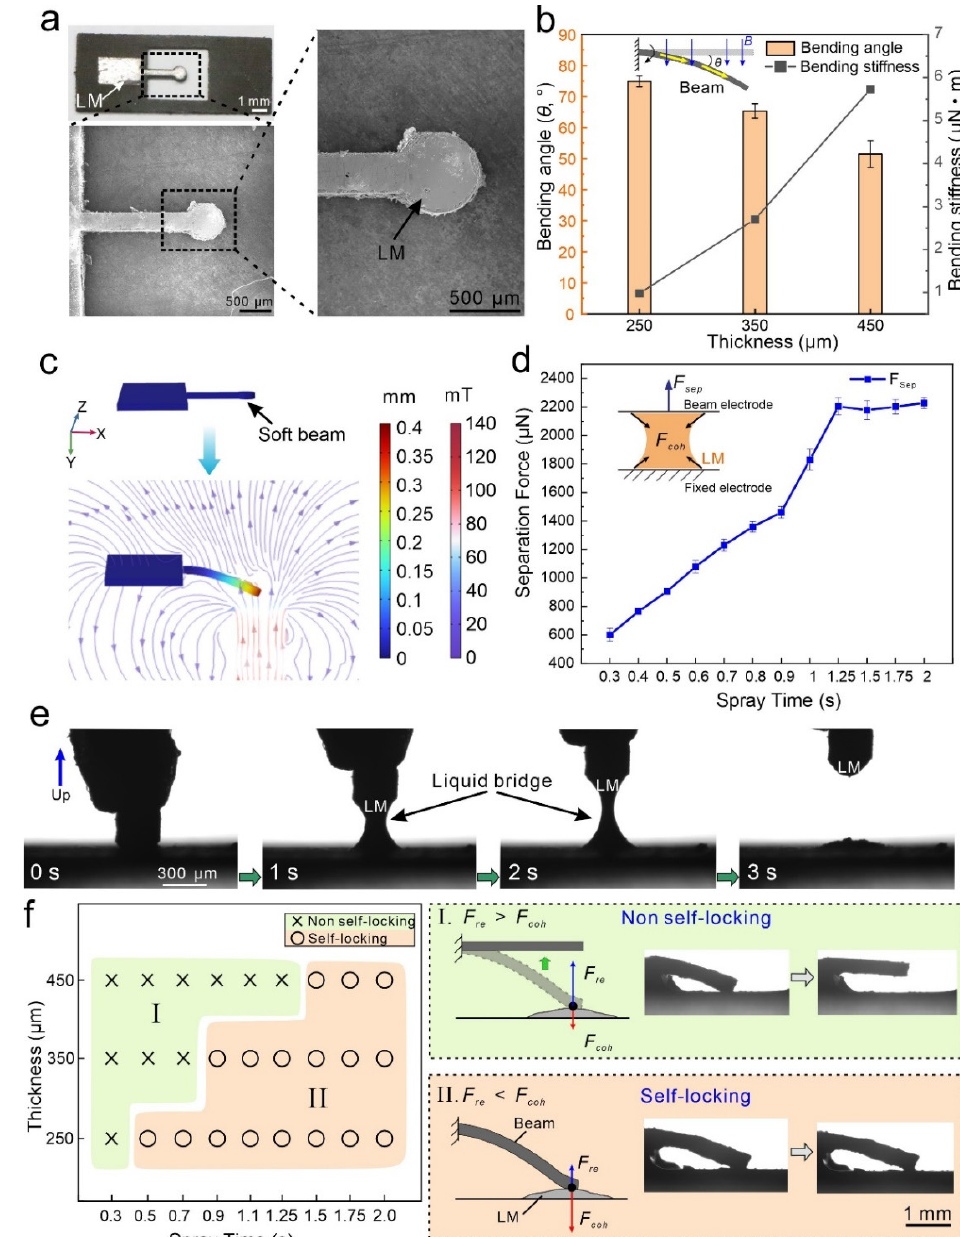
Figure 2. Working principle. ( a ) SEM photos of the beam electrode. ( b ) Bending angle and bending stiffness of the soft beam with different thicknesses. ( c ) Numerical simulation of the soft beam bending status under a magnetic field. ( d ) Maximum separation force, F sep , of electrodes with different spray times. ( e ) Serial photos of the liquid bridge during the slow separation of electrodes. Separation speed = 1.5 mm/s. ( f ) Two states of the MCSM produced by different spray times and thicknesses of the soft beam, where F re is the resilience force of the soft beam, and F coh is the cohesion force between two electrodes.